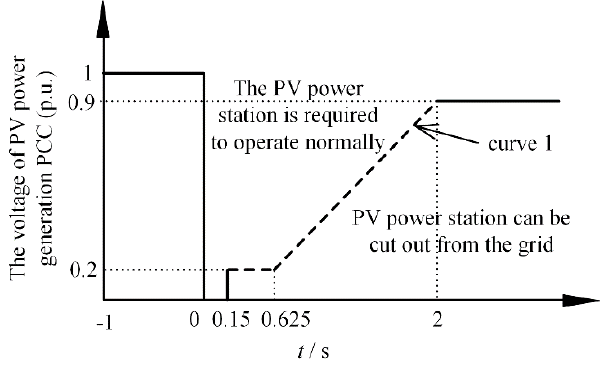
Figure 2. LVRT (low–voltage–ride–through) curves in Chinese grid code.